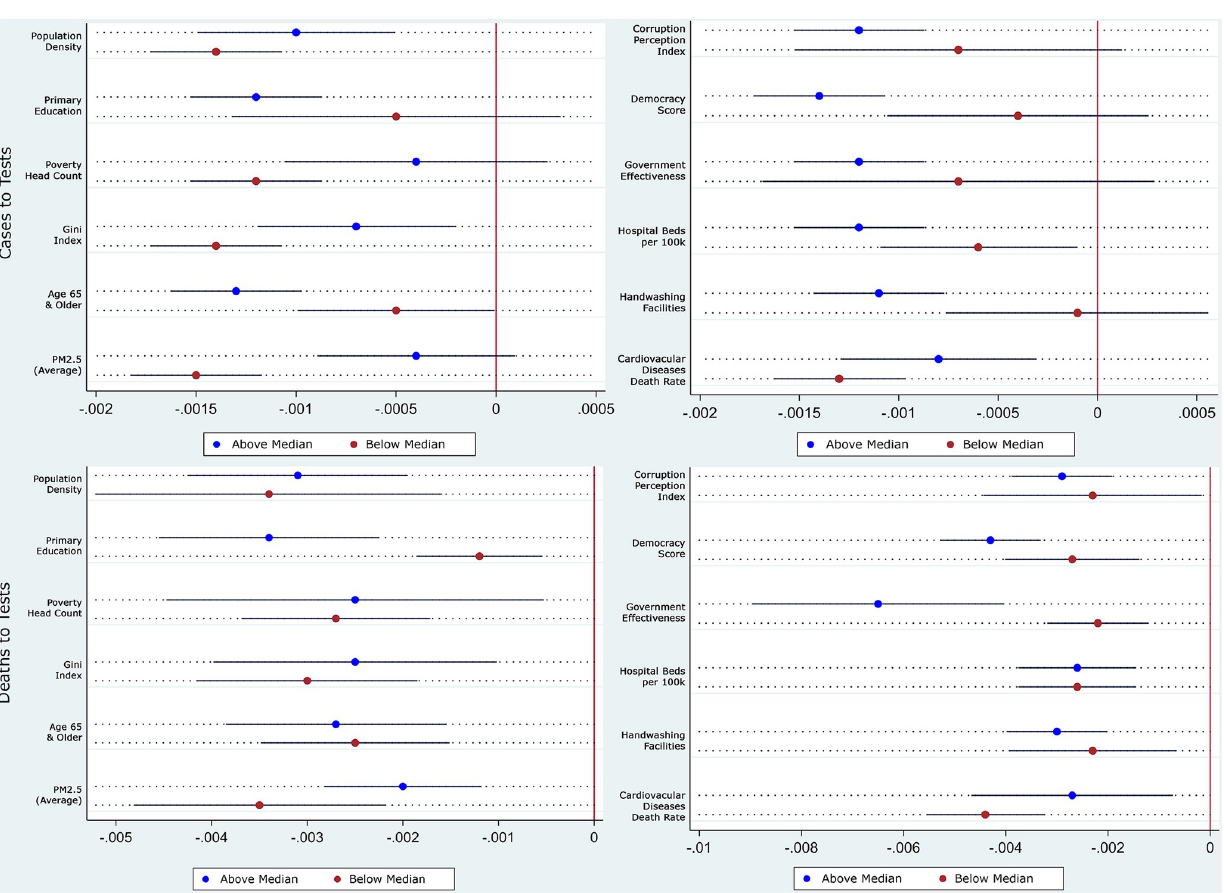
Fig 3. Coefficient plots of hetegeneous impact of stricter restriction on growth rates. Coefficient plots are constructed using results from Tables 6 and 7 with 90% confidence intervals.